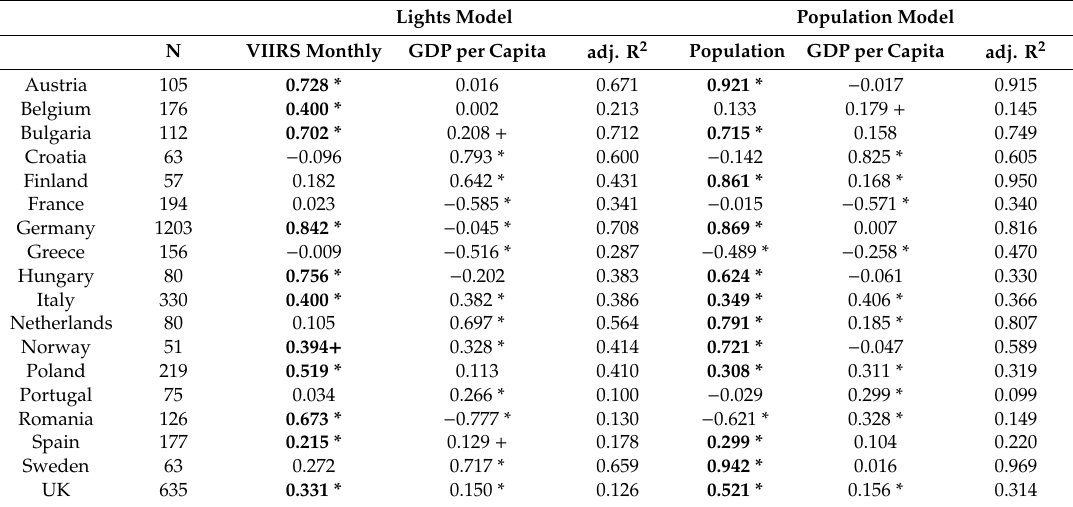
Table 4. Regression results for VIIRS averaged monthly lights versus results for